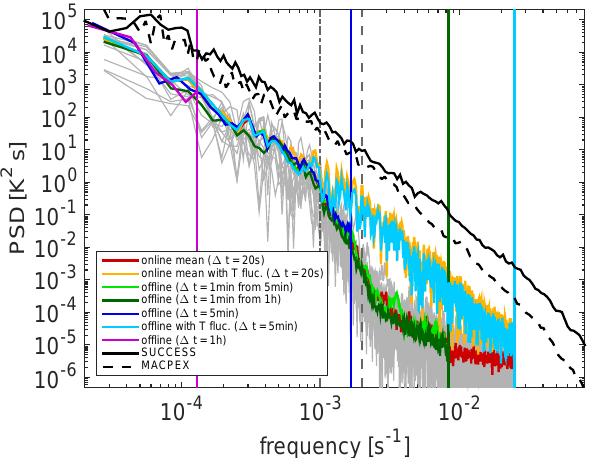
Figure 3. Power spectral densities (PSDs) of the temperature cal- culated for trajectories arriving above Jungfraujoch at 09:00UTC at 10.0–11.5km, where the cirrus cloud was observed by the lidar. Grey lines: PSDs of individual 20s online trajectories. Red line: average of the online trajectories. Orange: online trajectory with superimposed temperature fluctuations. Light green: offline trajec- tories based on 5min model output, interpolated to 1min resolu- tion. Dark green: based on 1h model output, interpolated to 1min. Dark blue: offline trajectories based on 5min COSMO-2 model output. Light blue: offline trajectories based on 5min COSMO- 2 model output with superimposed small-scale temperature fluc- tuations. Purple: offline trajectories based on 1h model output. Coloured vertical lines: Nyquist frequency for each specific tem- poral resolution. Black solid curve: PSD derived from aircraft data sampled during the SUCCESS campaign. Black dashed curve: same but for the MACPEX campaign. Dashed vertical line: maximum frequency that can be resolved on the COSMO-Model grid given the finite horizontal resolution and the mean horizontal velocity along the trajectories ( f max = 17 . 4ms − 1 /( 4 × 2 . 2km) ≈ 2 × 10 − 3 s − 1 ). Dashed-dotted vertical line: cut-off frequency using 8 (cid:49)x as effec- tive model